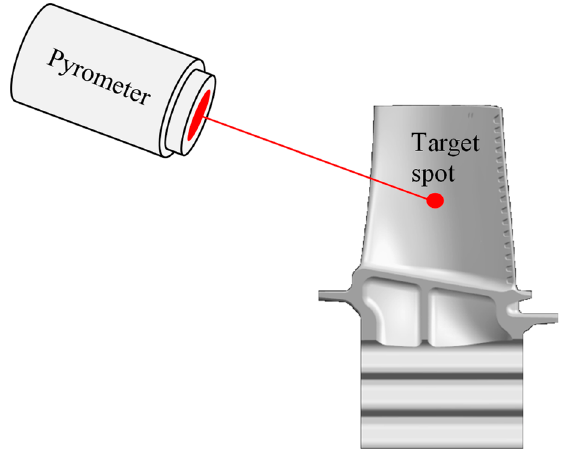
Figure 20 . Principle pyrometry . Figure 20. Principle